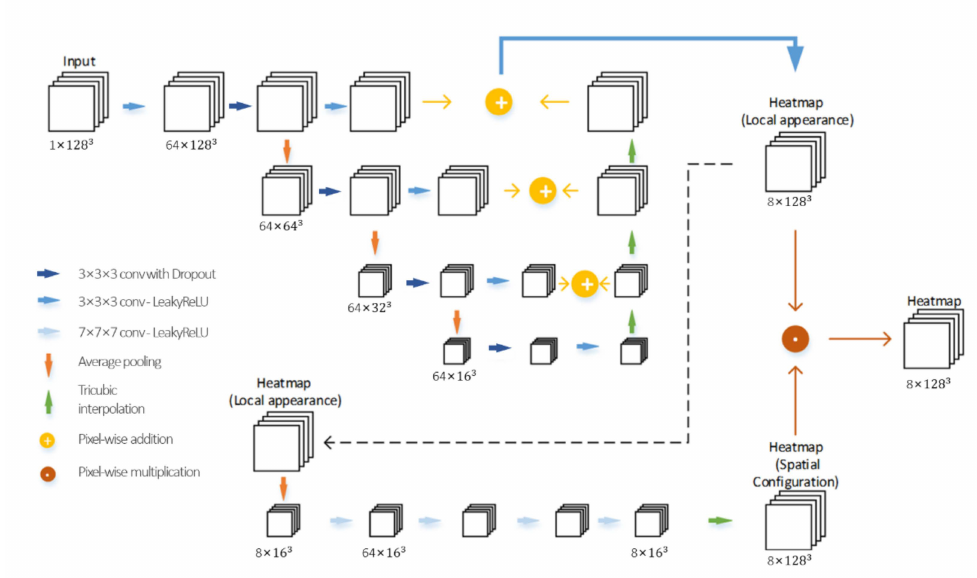
Figure 2. SCN architecture for landmark